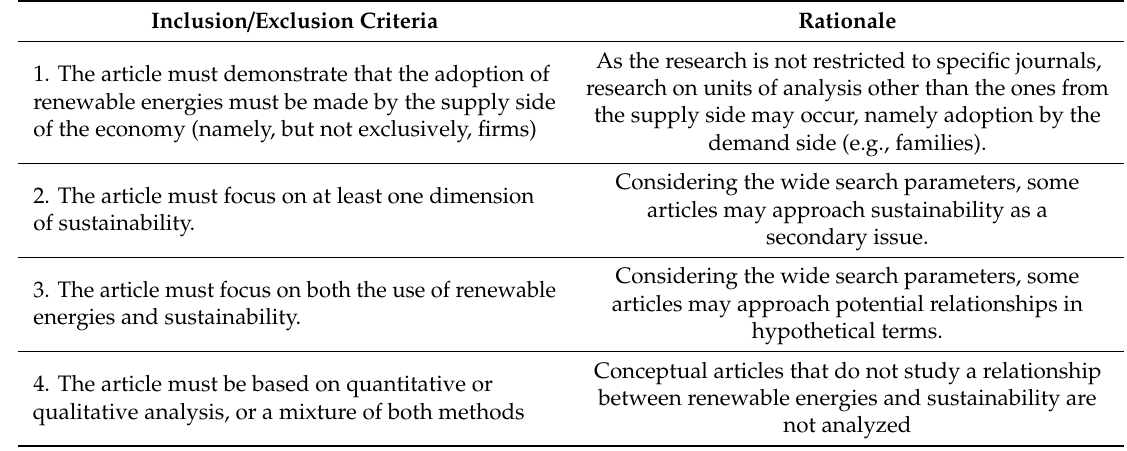
Table 1. Appraisal Step (ii): inclusion and exclusion